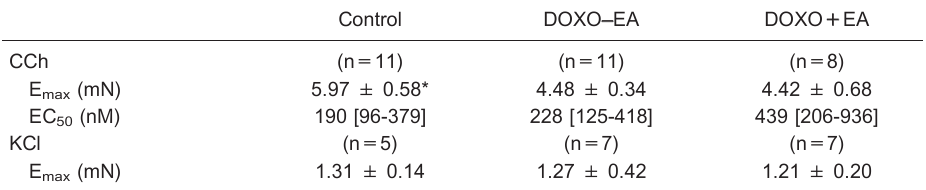
Table 1. Values of E max for CCh and KCl and values of EC 50 for CCh in segments of the distal esophagus.